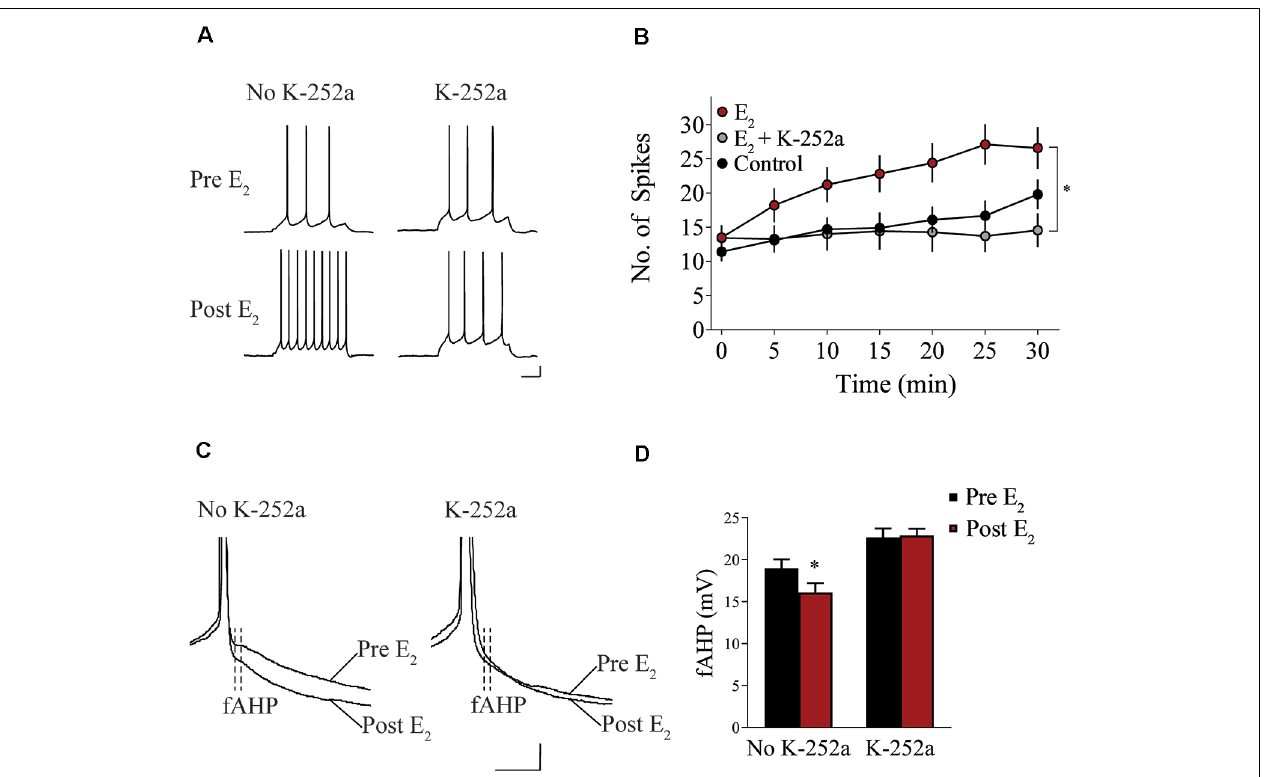
FIGURE 3 | Blockade of tropomyosin-related kinase (Trk) receptors prevents E 2 -induced potentiation of IL-mPFC neuronal intrinsic excitability. (A) Individual traces of current-evoked APs from IL-mPFC neurons that were not incubated in K-252a (left) or were incubated in K-252a (right), before (top) and after (bottom) bath-application of E 2 . Scale bars, 10 mV (vertical) and 500 ms (horizontal). (B) IL-mPFC neurons treated with E 2 ( n = 10) have increased intrinsic excitability compared to aCSF alone ( n = 10) or neurons that were incubated in K-252a prior to bath-application of E 2 ( n = 7). (C) Representative waveforms showing fast afterhyperpolarization (fAHP) in neurons that were not incubated in K-252a (left) or were incubated in K-252a (right), and after bath-application of E 2 . Scale bars, 10 mV (vertical) and 10 ms (horizontal). (D) E 2 suppresses fAHP and this effect was blocked in the presence of Trk receptor antagonist, K-252a. ∗ p < 0.05. Error bars indicate SEM.